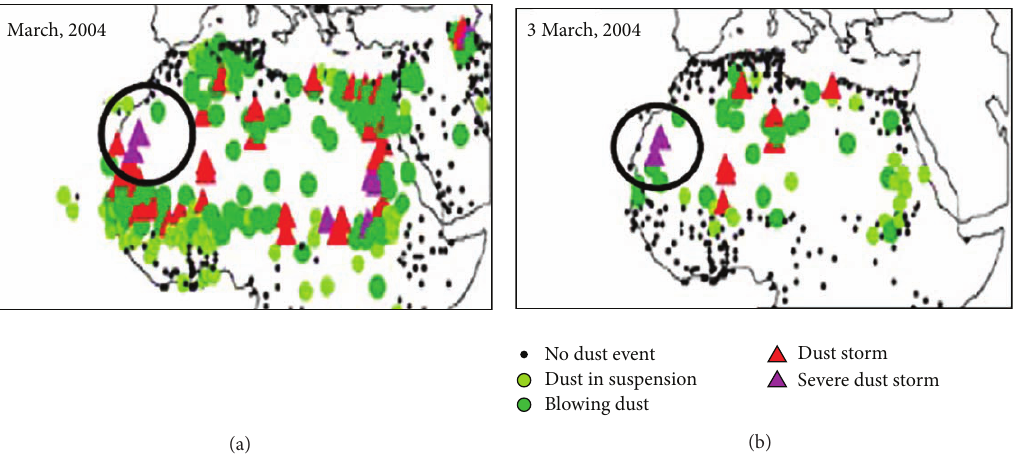
Figure 10: Distribution of the surface weather stations in North Africa (black dots) and daily dust weather records for the period 3 March 2004 (a). The dust weather records for the entire month of March 2004 are shown in (b), (shaded) and the dust weather records (symbols) for 3 March 2004